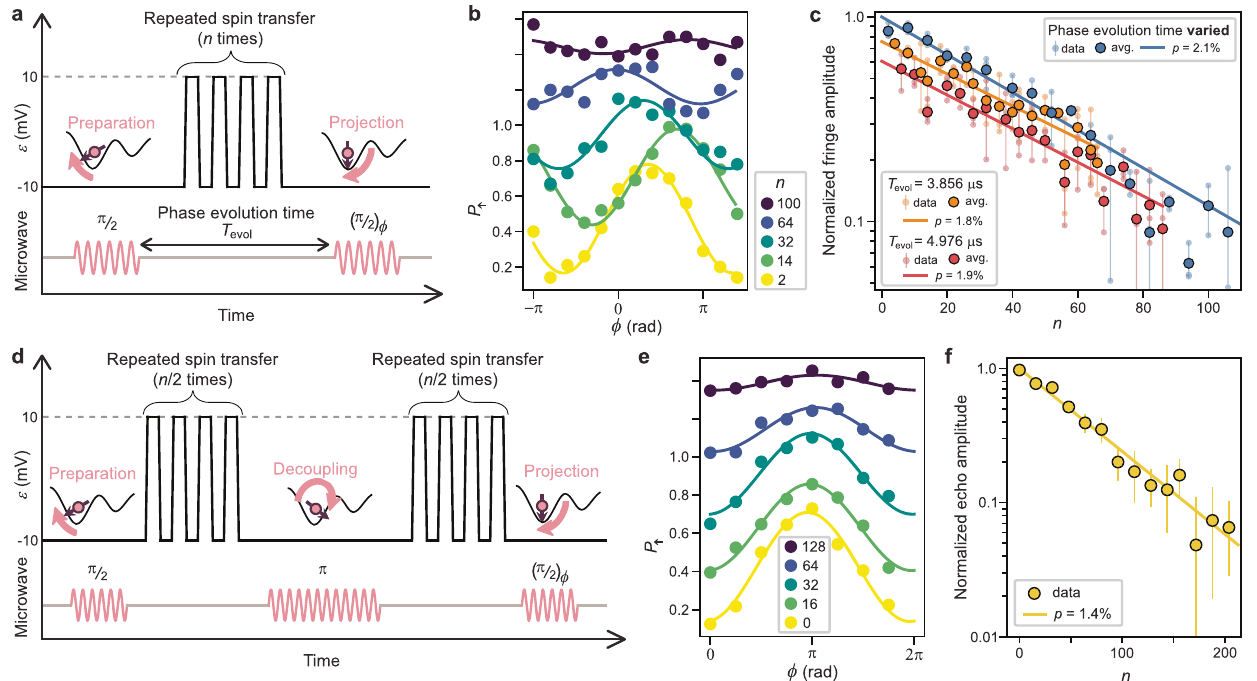
Fig. 4 Coherent transfer fi delity characterization. a Pulse sequence for shuttle fi delity characterization. Transport ramps are repeated a number ( n ) of times between the two π /2 pulses, whose interval is denoted as the phase evolution time, T evol . b Fringes observed after shuttle ramps for various n (with varying T evol ). Curves plot the fi t results. Traces are offset for clarity. c Normalized fringe amplitudes as a function of n with T evol varied (blue) or fi xed (orange and red). Curves plot the (normalized) results of fi tting to the exponential function A 1 (cid:2) p ð Þ n þ C . In addition to A and p , C is set as a free parameter when we fi t the data with T evol varied, and its best- fi t value C = 4 × 10 − 11 is assumed for the data with T evol fi xed (and hence with smaller maximum values of n ). Smaller decay amplitudes for the data with T evol fi xed are consistent with the expected reduction of coherence during T evol . d Pulse sequence for echoed shuttle fi delity characterization. All microwave pules are applied at tone A and with the spin in site A. e Echo fringes observed for various n along with the fi t results. f Normalized echo amplitudes as a function of n with a fi t to an exponential decay. Error bars represent the 1 σ con fi dence intervals of the echo